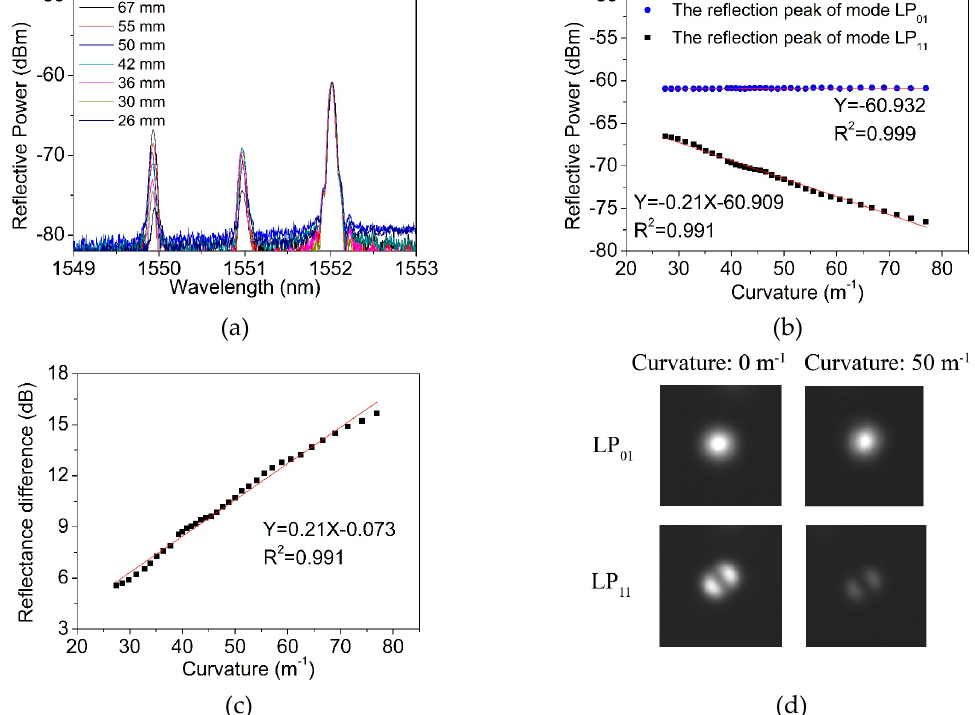
Figure 9. The experimental ( a ) reflection spectra, ( b ) peak intensity, ( c ) the difference of reflectivity intensity of two-mode FBG and ( d ) the transmission mode field with the curvature change.